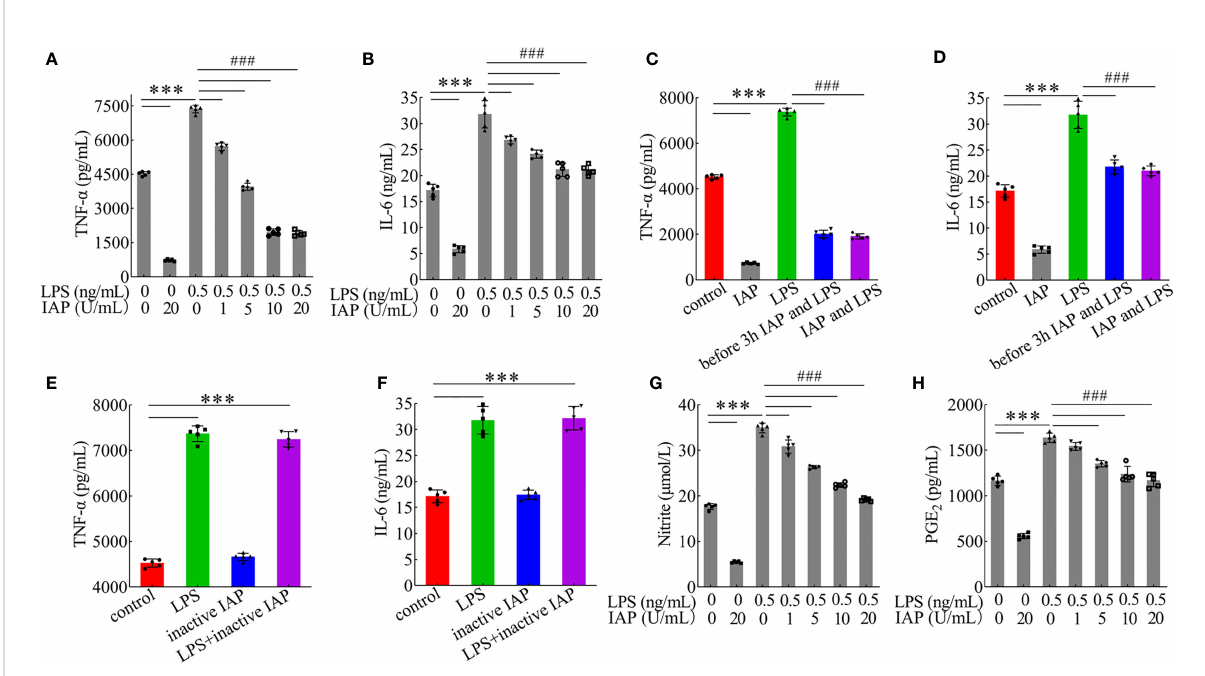
FIGURE 5 Effect of IAP in the in fl ammatory response induced by LPS. The effect of different IAP activity on LPS-induced (A) TNF- a and (B) IL-6 in cocultured HT-29 cells + freshly extracted human leucocytes. Different IAP and LPS incubation methods (IAP and LPS were added after incubation for 3 h, or IAP and LPS were added simultaneously) on the secretion of (C) TNF- a and (D) IL-6 in cocultured HT-29 cells + freshly extracted human leucocytes. Inactivation of IAP on LPS induced (E) TNF- a and (F) IL-6 in cocultured HT-29 cells + freshly extracted human leucocytes. The effect of different IAP activity on LPS-induced (G) NO and (H) PGE 2 in cocultured HT-29 cells + freshly extracted human leucocytes. Values are presented as means ± SD (n = 5 wells/group). Analysis of variance with Tukey. Compared with the control, ***P < 0.001, compared with the LPS, ### P <